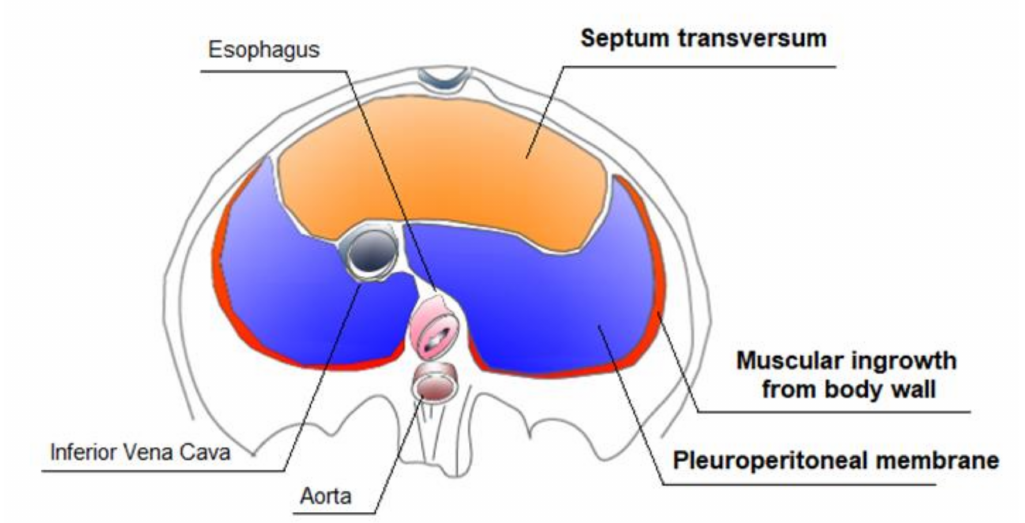
Figure 3. Development of the